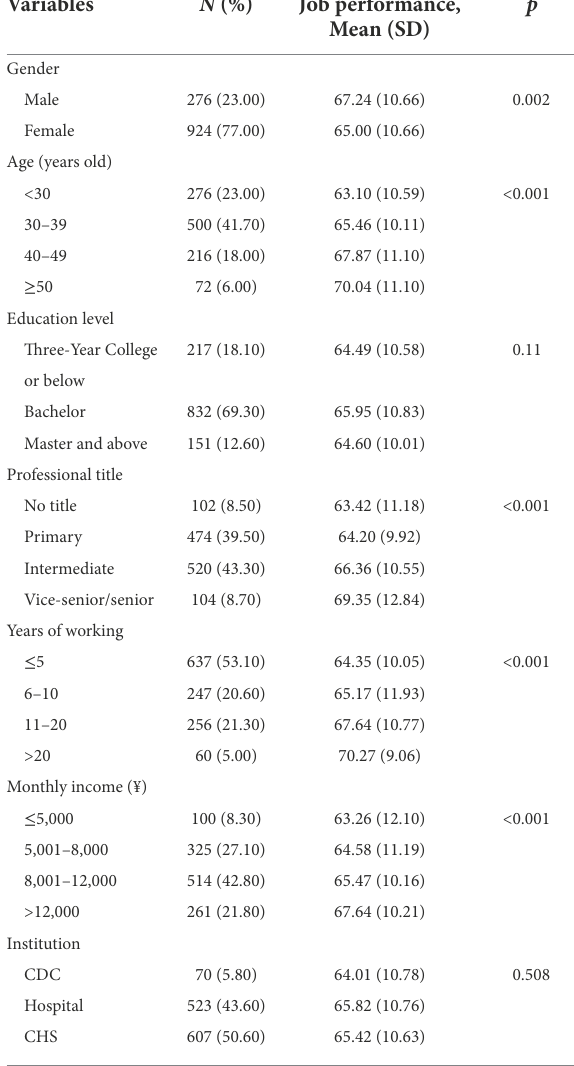
TABLE 1 Respondent